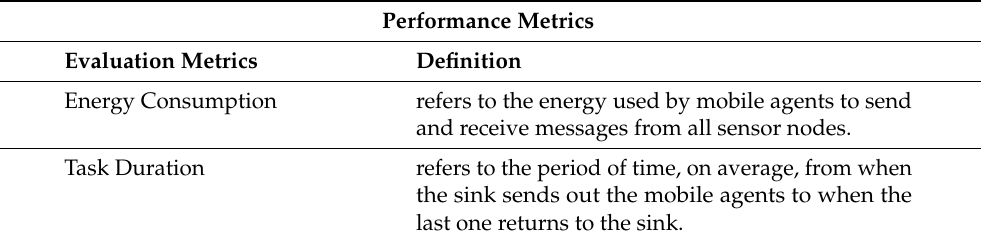
Table 3. Performance metrics for experimental